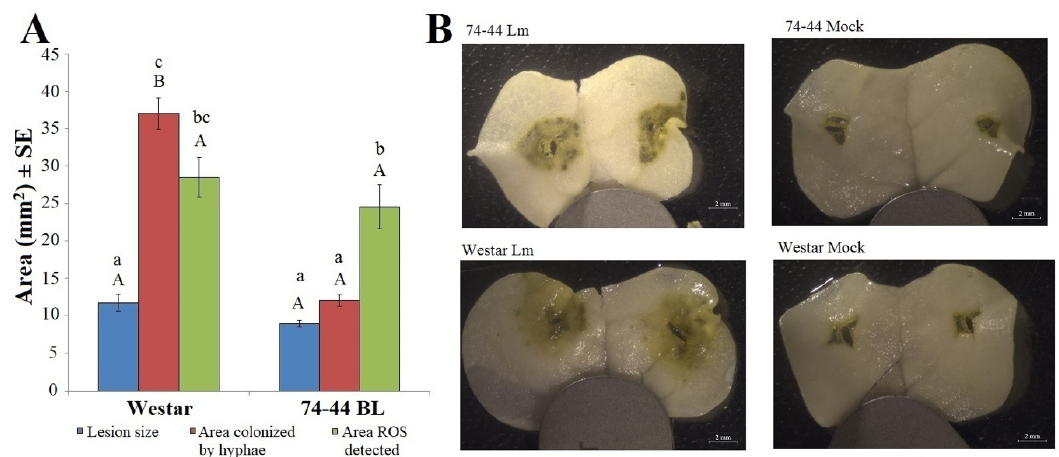
Figure 6. The area of visible lesions, Lm hyphal colonization and positive staining for HP(a ROS) in the cotyledons of Westar and 74-44 BL at 7 dpi with the L. maculans isolate 12CC09-GFP. Bars with the same letter of the same case are not significantly different ( A ). Capital letters indicate comparisons between the cultivars for a given parameter (Wilcoxon two-sample test, p ≤ 0.05). Lower case letters denote comparisons between parameters, within a cultivar (Tukey adjusted, p ≤ 0.05). Panel ( B ) shows the appearance of representative HP staining reactions on cotyledons. Plants 2020 , 9 , x